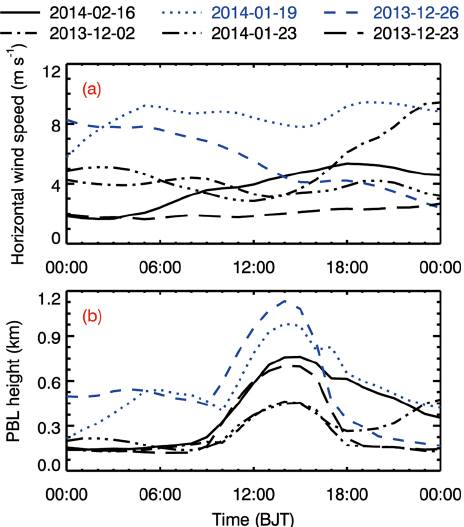
Figure 8. Temporal variations of the area averaged low-level (a) wind speeds and (b) PBL height over the basin on 16 Febru- ary 2014 (“north-low”), 19 January 2014 (“southwest-trough”), 26 December 2013 (“southeast-high”), 2 December 2013 (“tran- sition”), 23 January 2014 (“southeast-trough”), and 23 December 2013